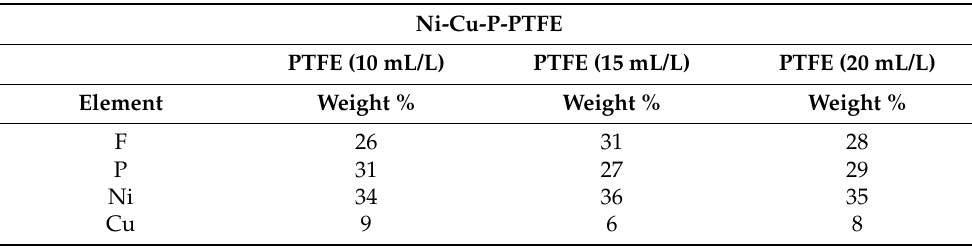
Figure 3. Surface energy spectrum of Ni-Cu-P-PTFE composite plating: PTFE (10 mL/L) ( a – d ); PTFE (15 mL/L) ( e – h ); PTFE (20 mL/L) ( i – l ). Table 2. Percentage of each element on the surface of Ni-Cu-P-PTFE composite coating with different PTFE concentrations.